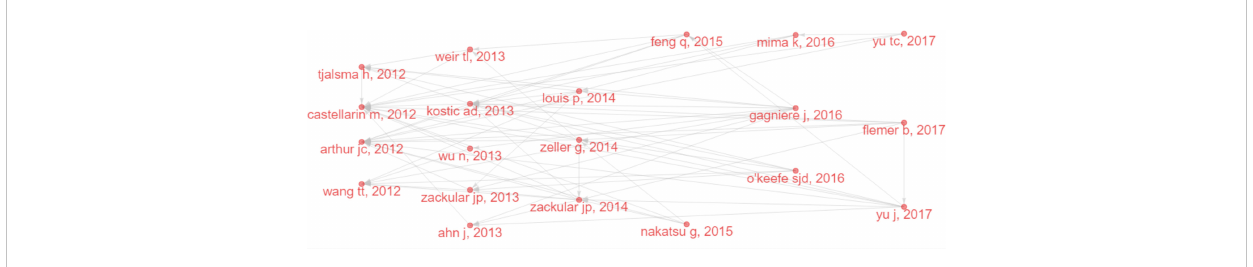
FIGURE 7 Historical direct citation network in IM/CRC (gray lines indicate the citation relations, and each dot represents a paper by author and